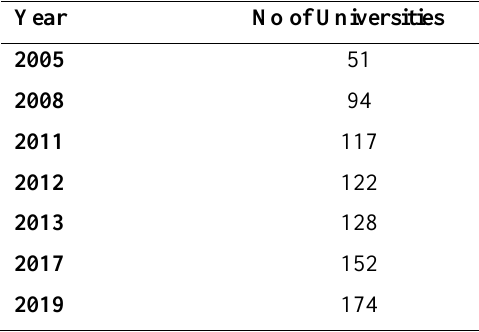
Table 2. The Growth of the Nigerian Universities from 2005–2019 (World Education Services, 2017; National Universities Commission,